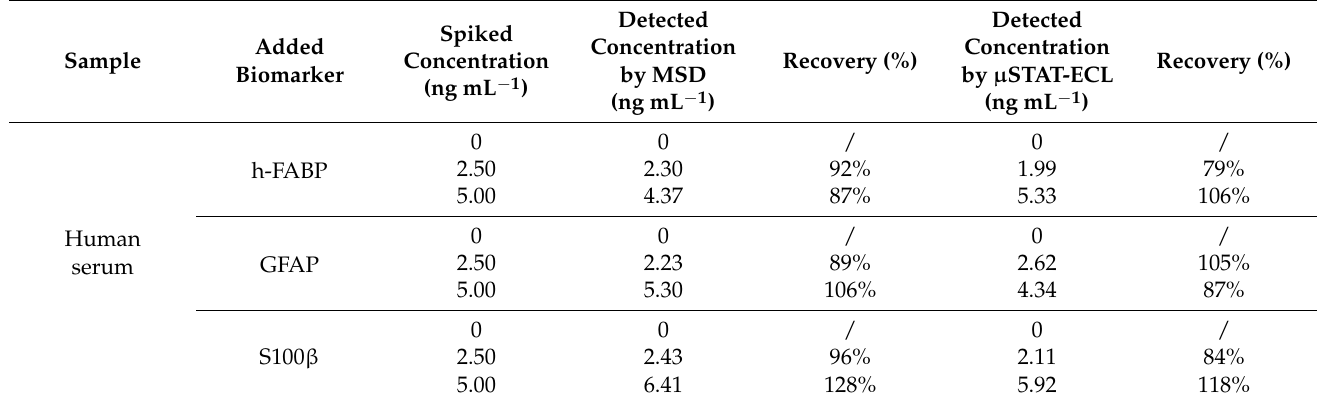
Table 5. Results of the recovery test for mTBI biomarkers in human serum (HS, n = 2) samples diluted 2 × with respective assay diluent (details of the assay conditions are listed in Table